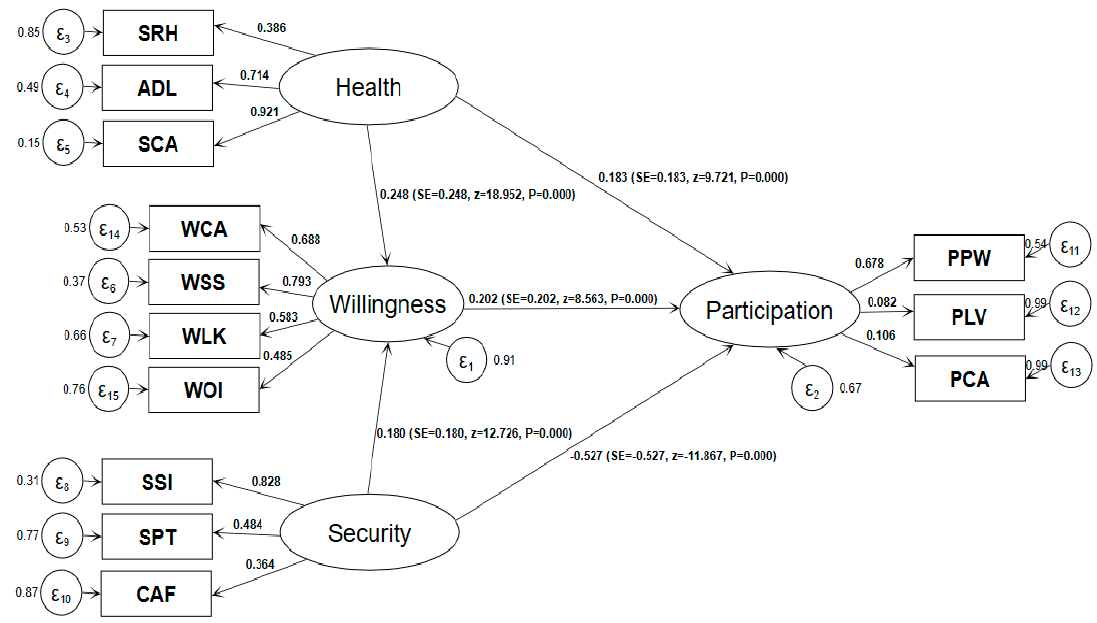
Figure 3. Model estimation results (standardization coefficient). Note: Maximum likelihood estimation, Satorra–Bentler standard error; N = 8061; ll = − 201259.01; R 2 = 0.969; SRMR = 0.072.